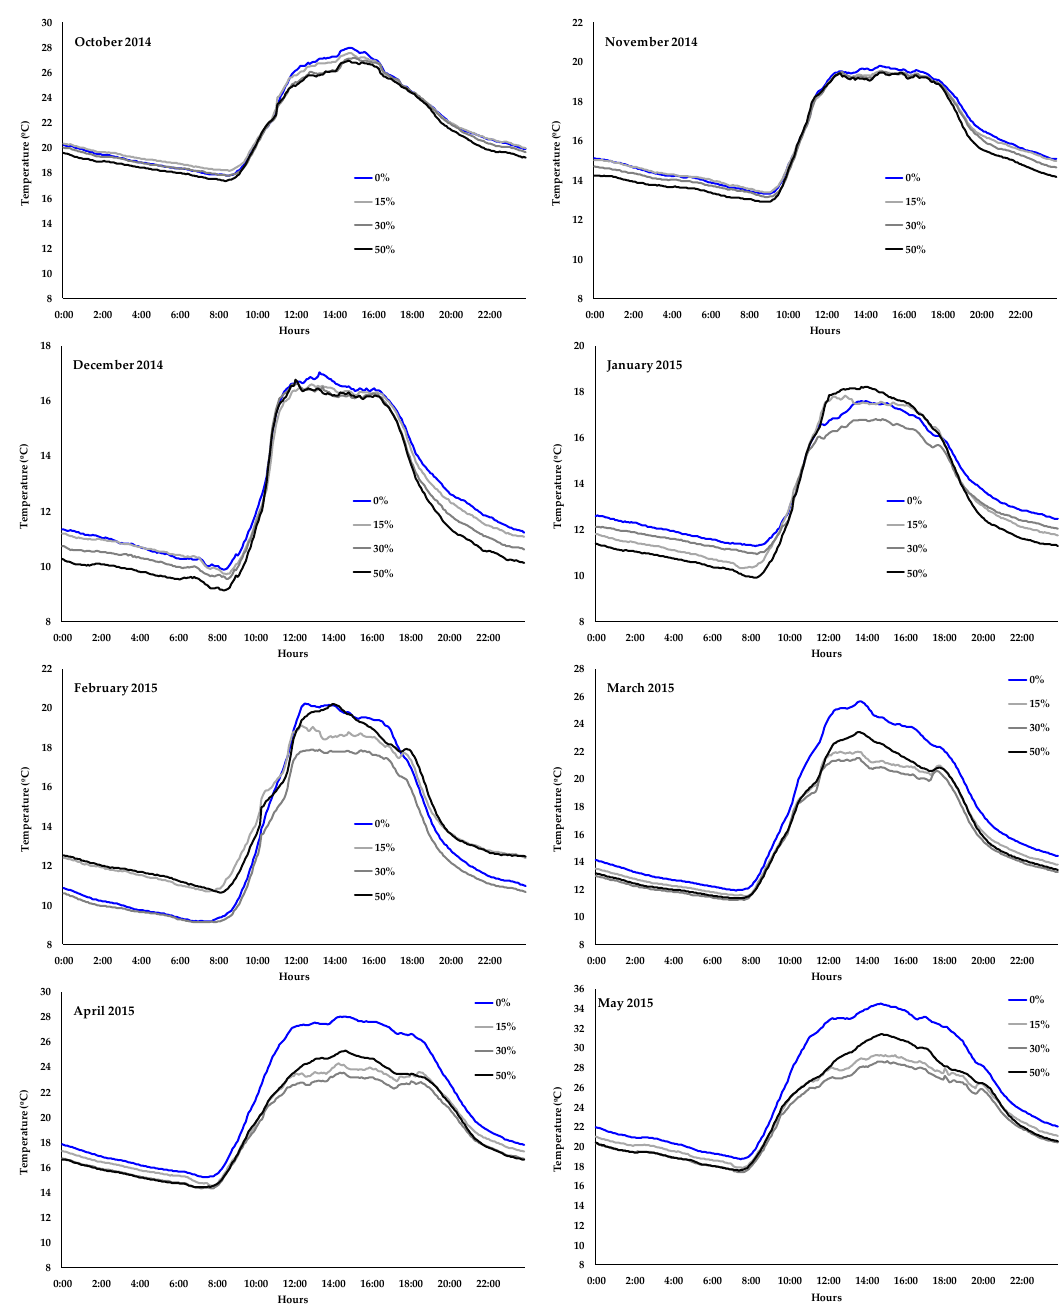
Figure 10. Average daily evolution of temperature in shadow treatments (0%, 15%, 30% and 50%) for the studied